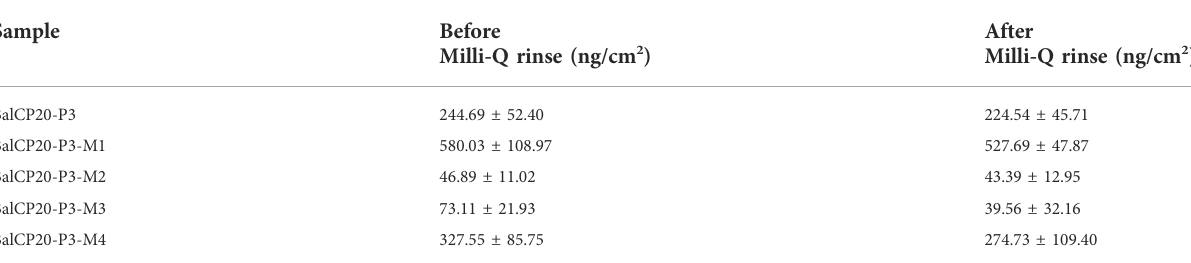
TABLE 2 Mass of bindings of BalCP20-P3 and its mutants.